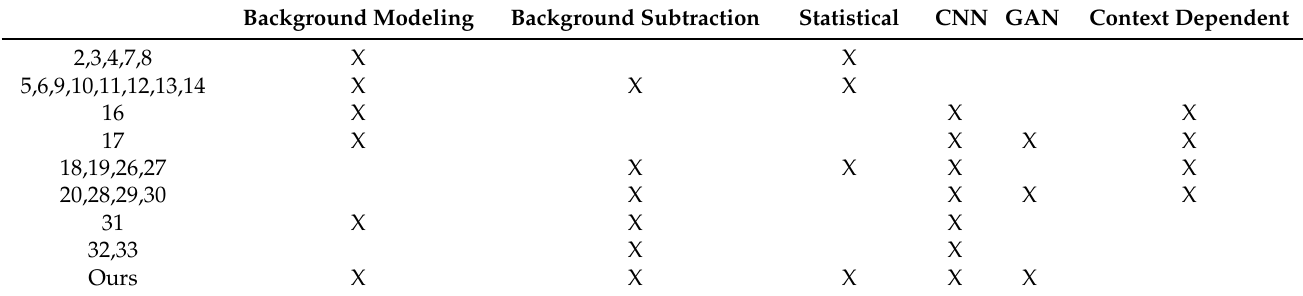
Table 1. Analysis of foreground segmentation